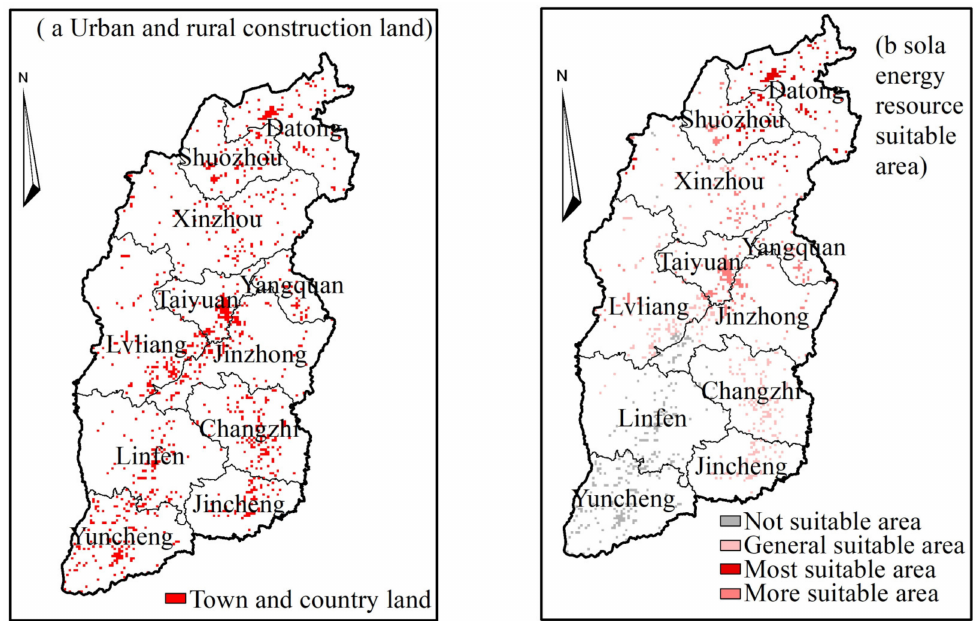
Figure 10. Urban and rural construction land and solar energy resource suitable area in Shanxi